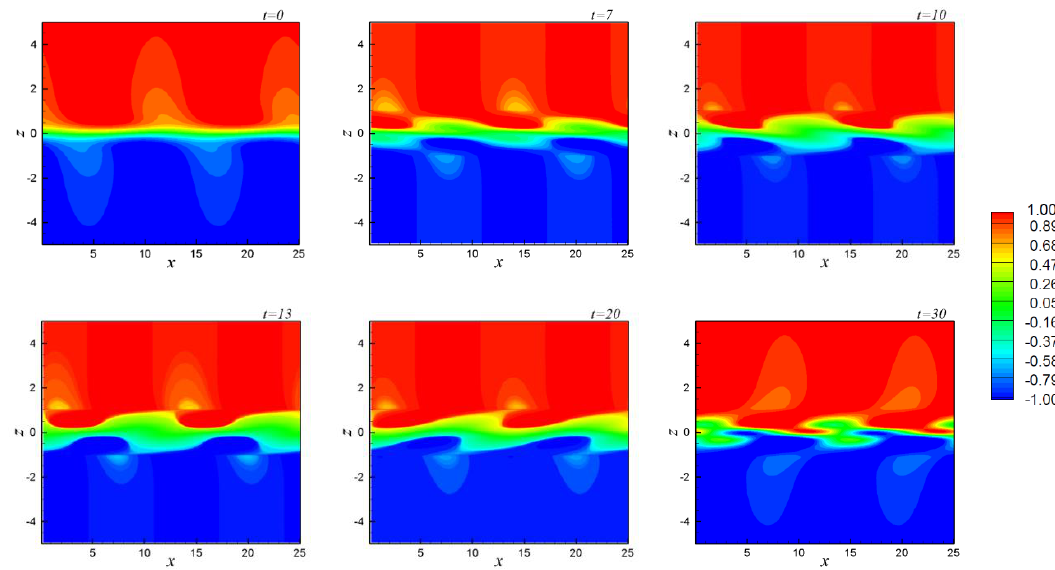
Figure 5. Snapshots of the base flow superposed with 2D optimal temperature perturbation calculated for the maximal growth at t max = 10. Ri = 1, Re = 1000, α = 0.5, β = 0. The blue color corresponds to cold fluid; the red color corresponds to warm fluid.